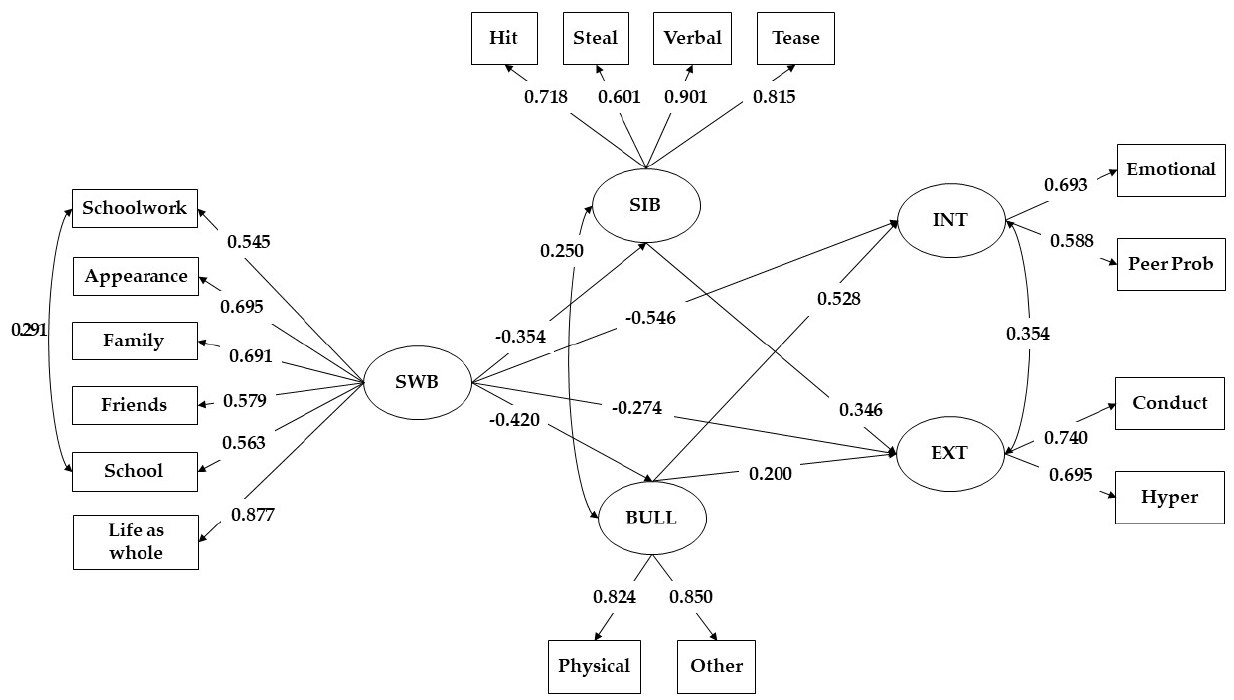
Figure 2. Path diagram of mediation model—statistically significant standardised coefficients